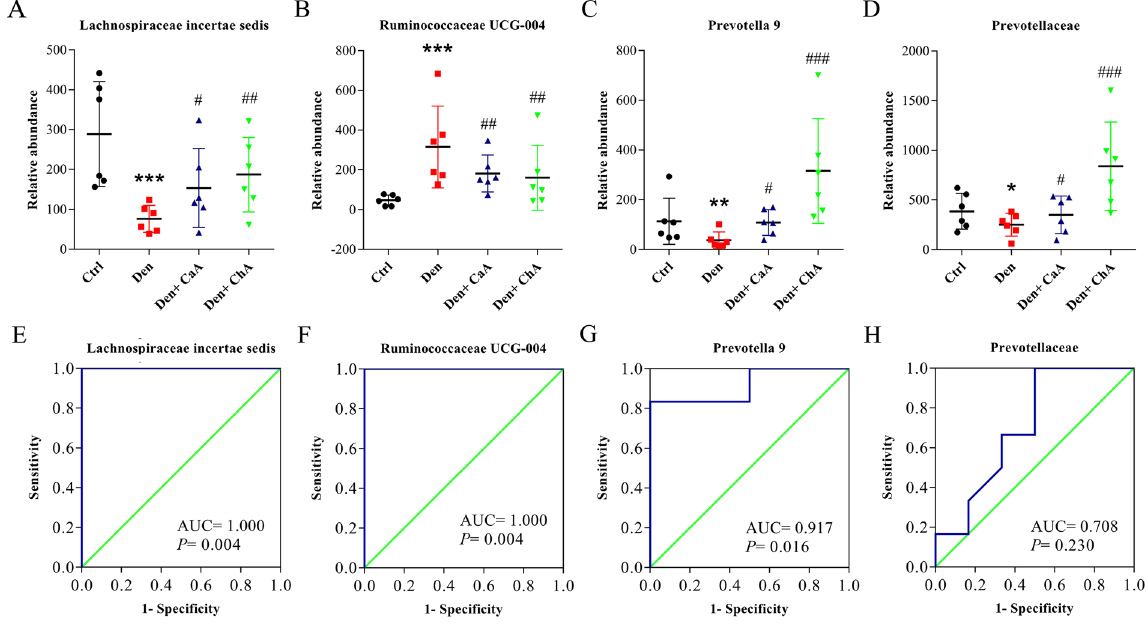
Figure 5. Taxonomic differences of fecal microbiota among control, DEN, DEN + CaA and DEN + ChA group. Comparsion of relative of ( A ) Lachnospiraceae incertae sedis , ( B ) Rumincoccaceae UCG-004 , ( C ) Prevotella 9 and ( D ) Prevotellaceae among these groups. The statistical difference was analyzed by Mann-Whitney U test. * P < 0.05, ** P < 0.01, *** P < 0.001 compared with control group; # P < 0.05, ## P < 0.01, ### P < 0.001, compared with DEN group. Receiver operating characteristic (ROC) curves for ( E ) Lachnospiraceae incertae sedis , ( F ) Rumincoccaceae UCG-004 , ( G ) Prevotella 9 and (H) Prevotellaceae were used to predict HCC.